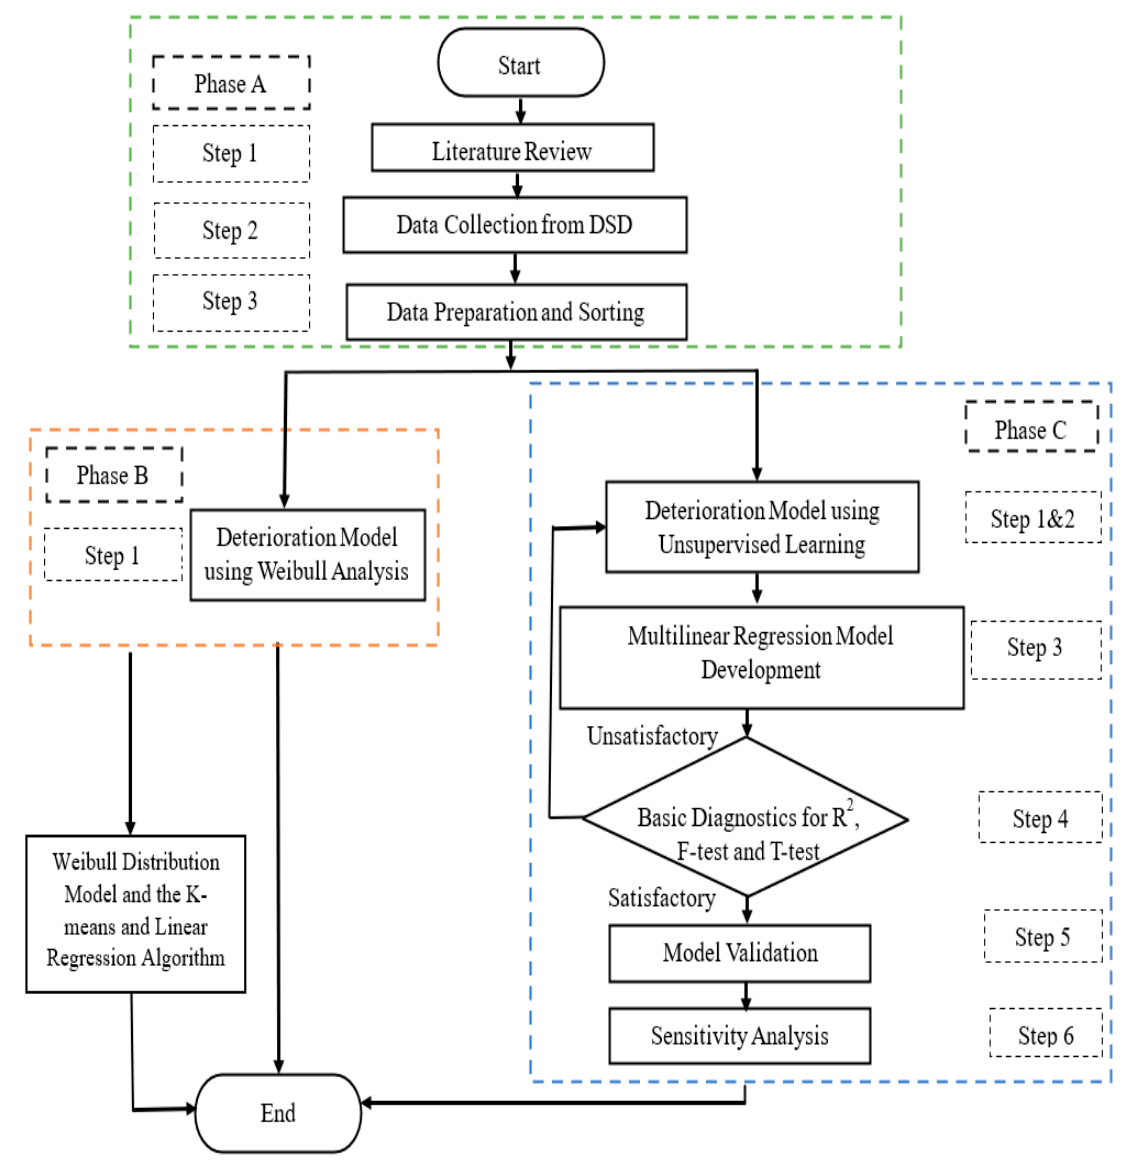
Figure 1. Research methodology.